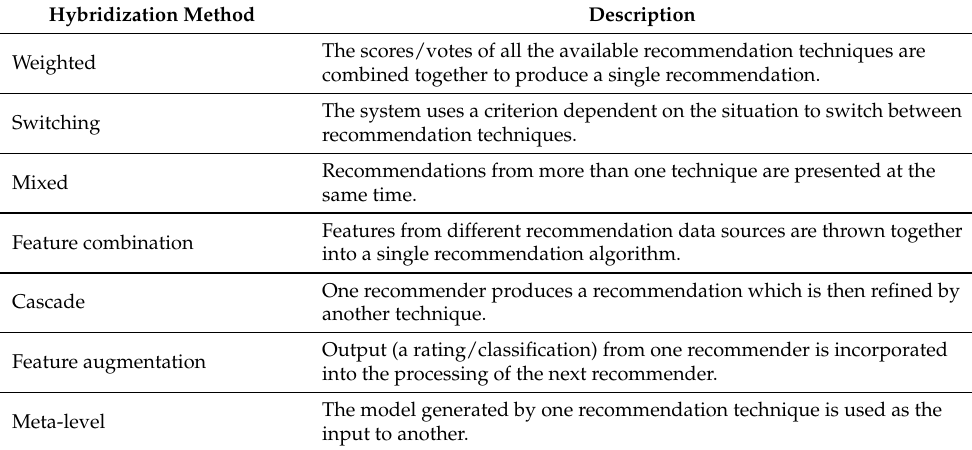
Table 3. The hybridization methods, based on [43]. Hybridization Method